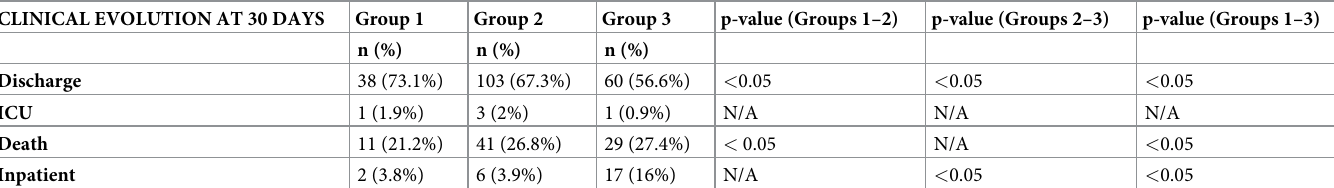
Table 4. Clinical evolution at 30 days in the different treatment groups.